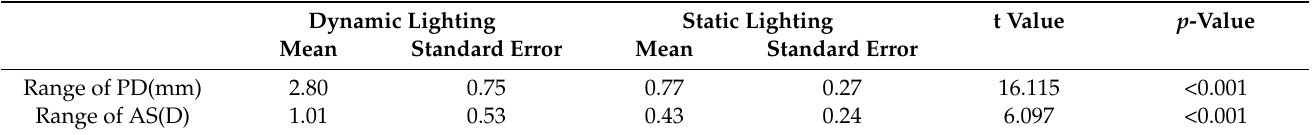
Table 1. Comparison of the effect of dynamic lighting and static lighting on human eye accommoda- tion response and pupil